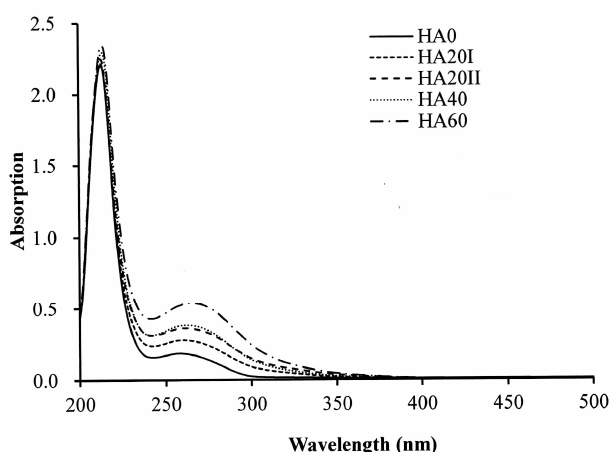
Figure 2. UV-Vis spectra of HA irradiated with various doses of γ -radiation. HA20I and HA20II are HA samples that received 20 kGy γ -irradiation once or twice, respectively. HA40 and HA60 represent the HA samples that received 40 kGy and 60 kGy γ -irradiation, respectively.